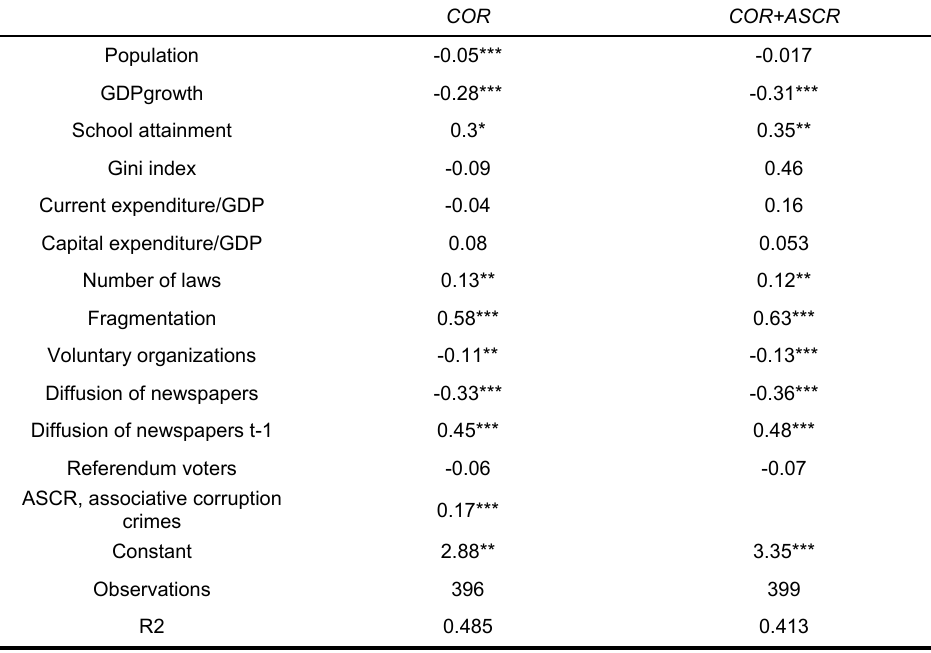
Table 3. Estimation of Equation 1